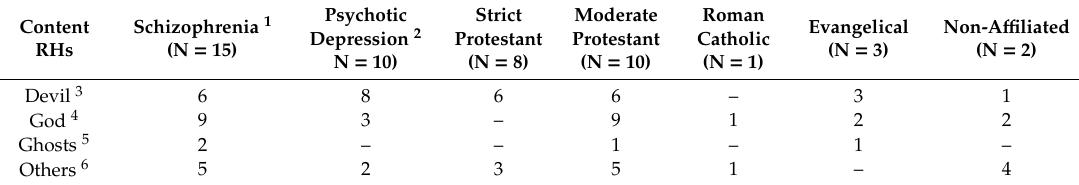
Table 3. Content of religious hallucinations in patients with the two most common diagnoses and their religious denominations (N =